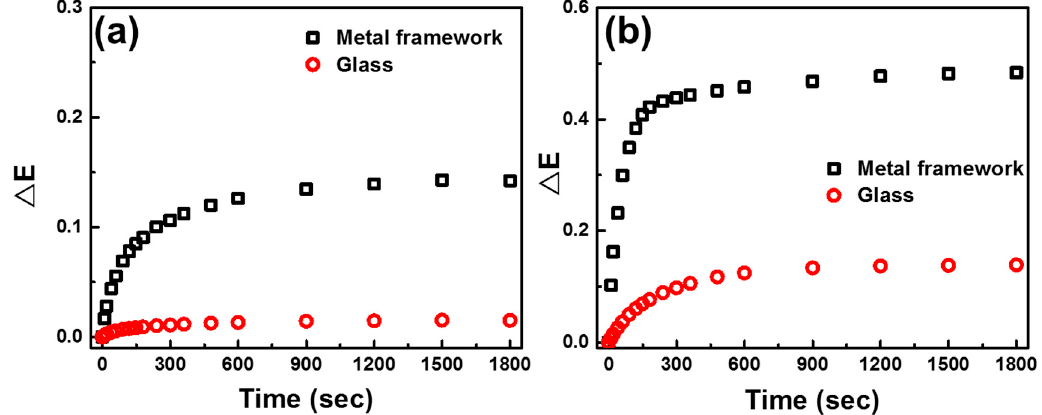
Figure 5. Extinction change of PANI/P3TI/PMMA fibers deposited on different substrates exposed to 2000 ppm n-butanol with ( a ) 20, and ( b ) 30 min of UV/ozone treatment.